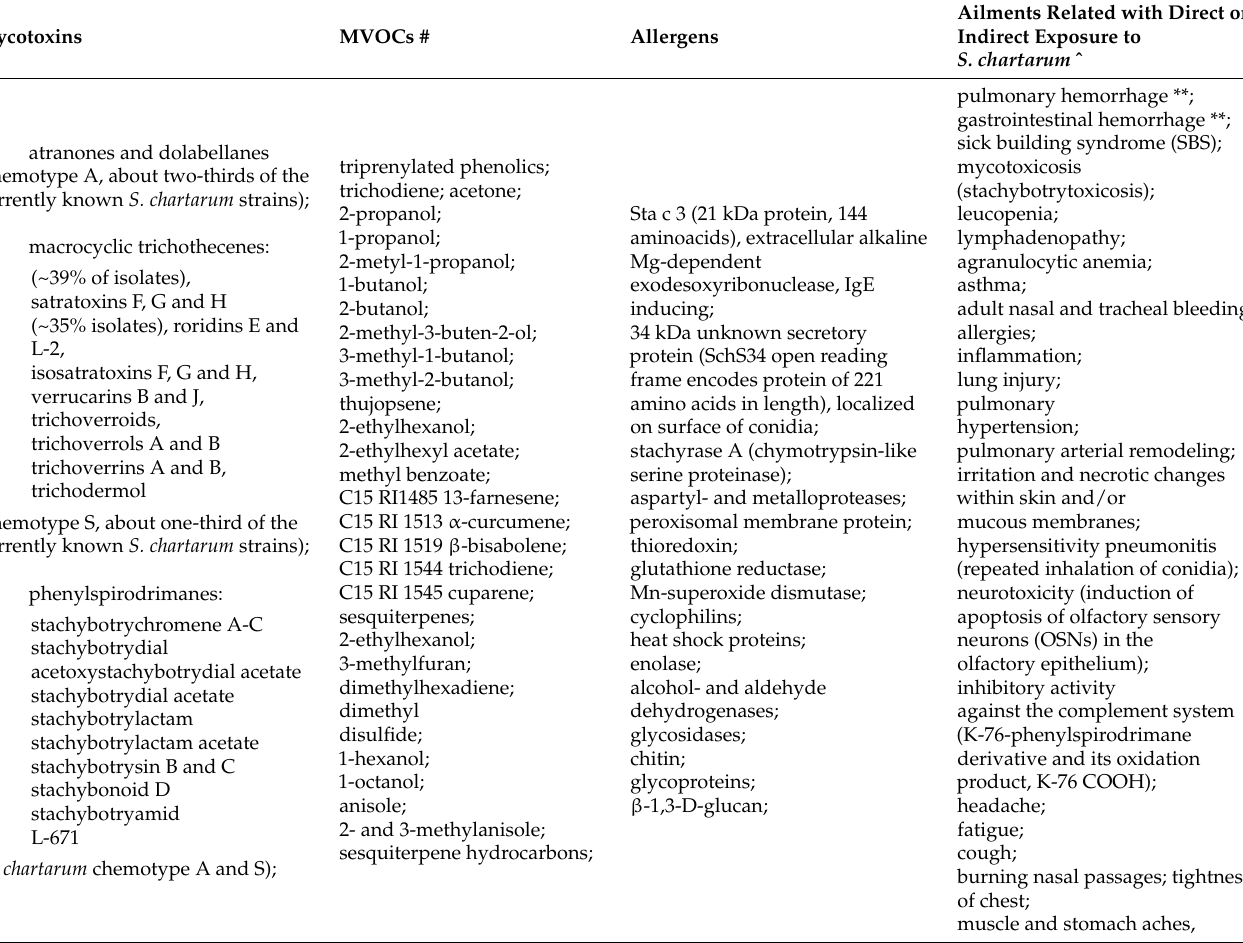
Table 2. Negative aspects related to the presence of S. chartarum in homes and dwellings *.